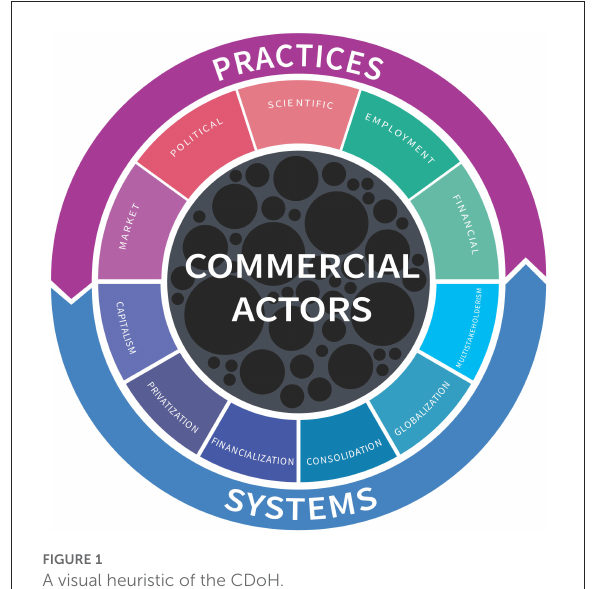
FIGURE1 A visual heuristic of the